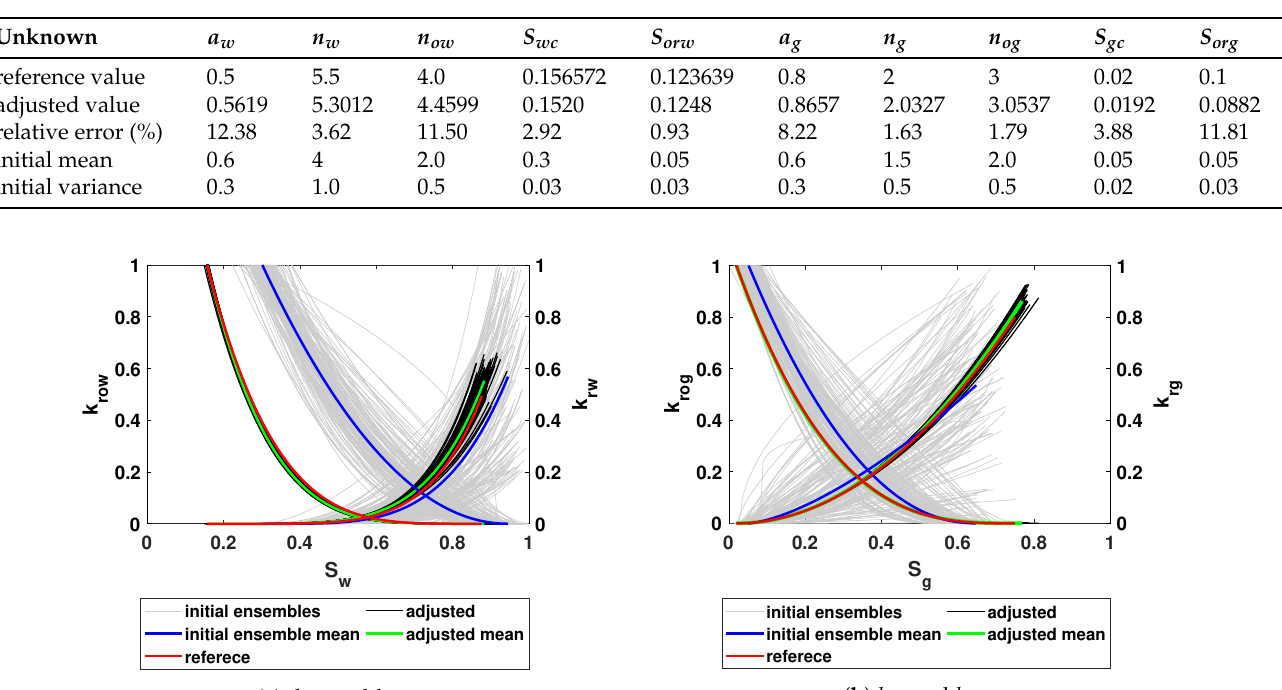
Table 4. This table shows the reference values, the adjusted values and the relative errors RE st at the last assimilation step, the initial ensemble means and variances of the ten parameters in Equation (12).